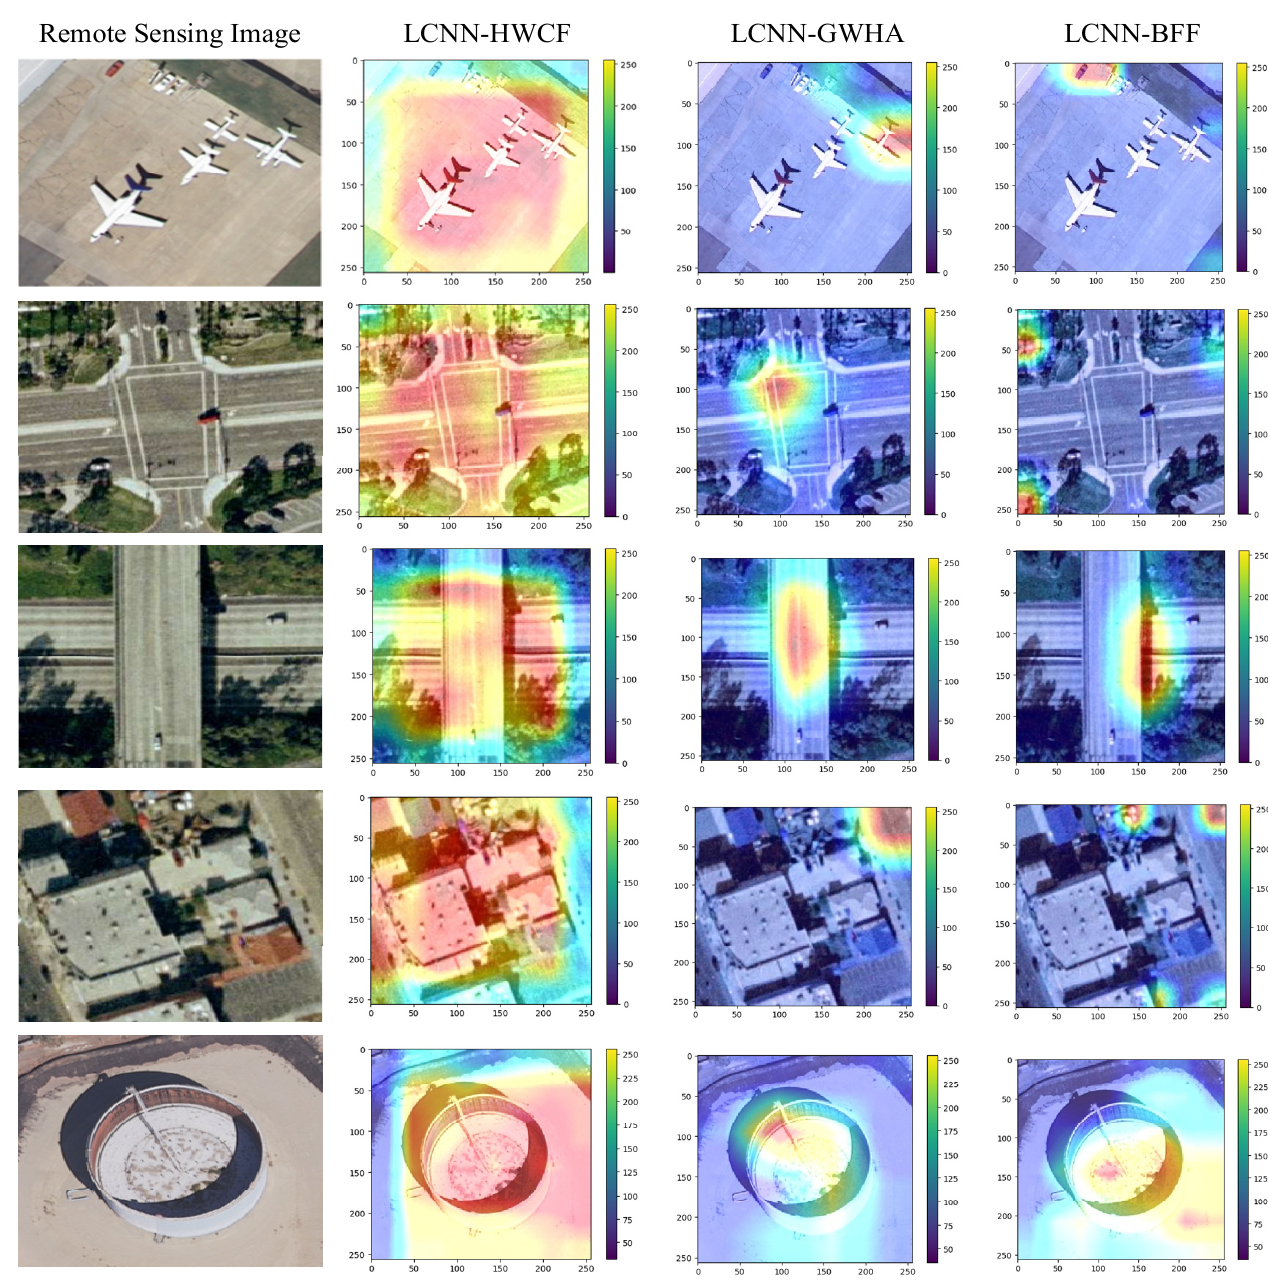
Figure 14. Grad cam visualization results.